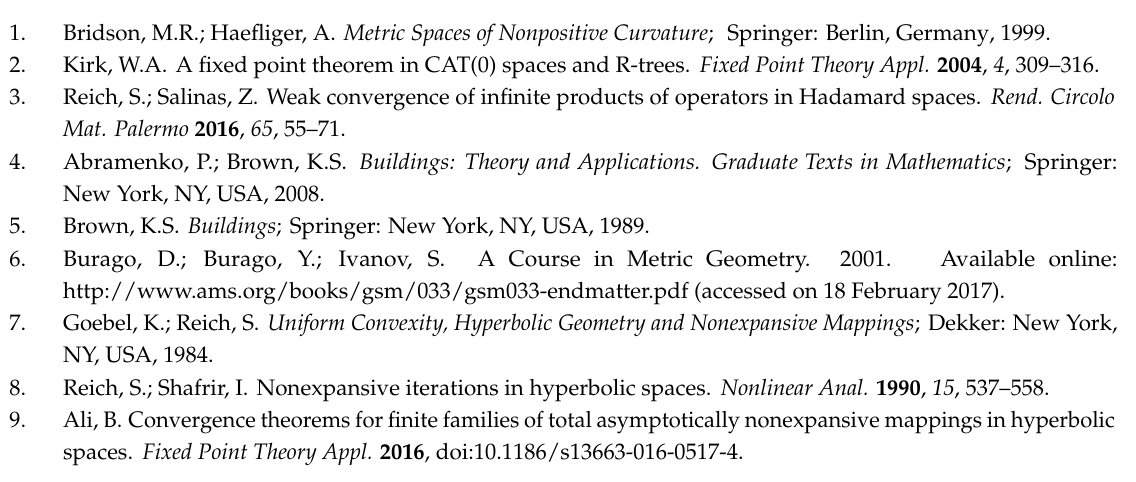
1 1 ) for 500 2, 2